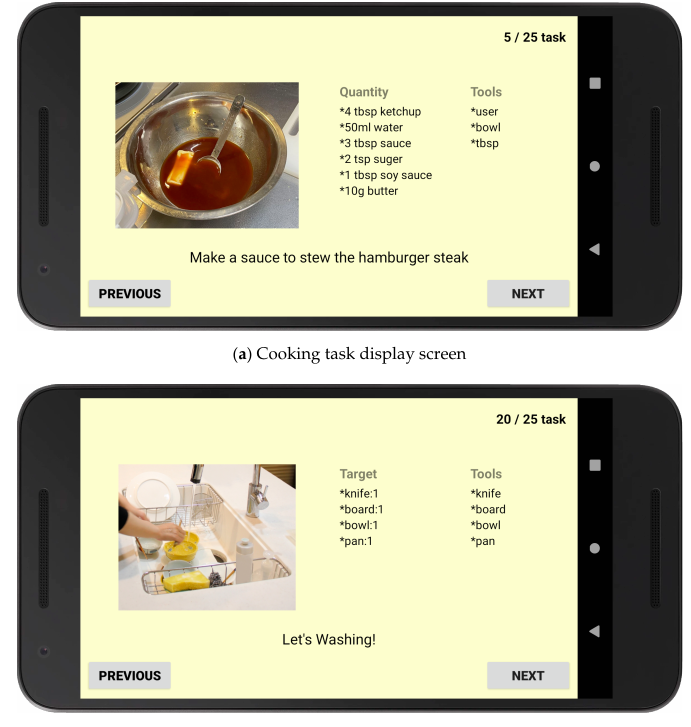
( b ) Washing task display screen